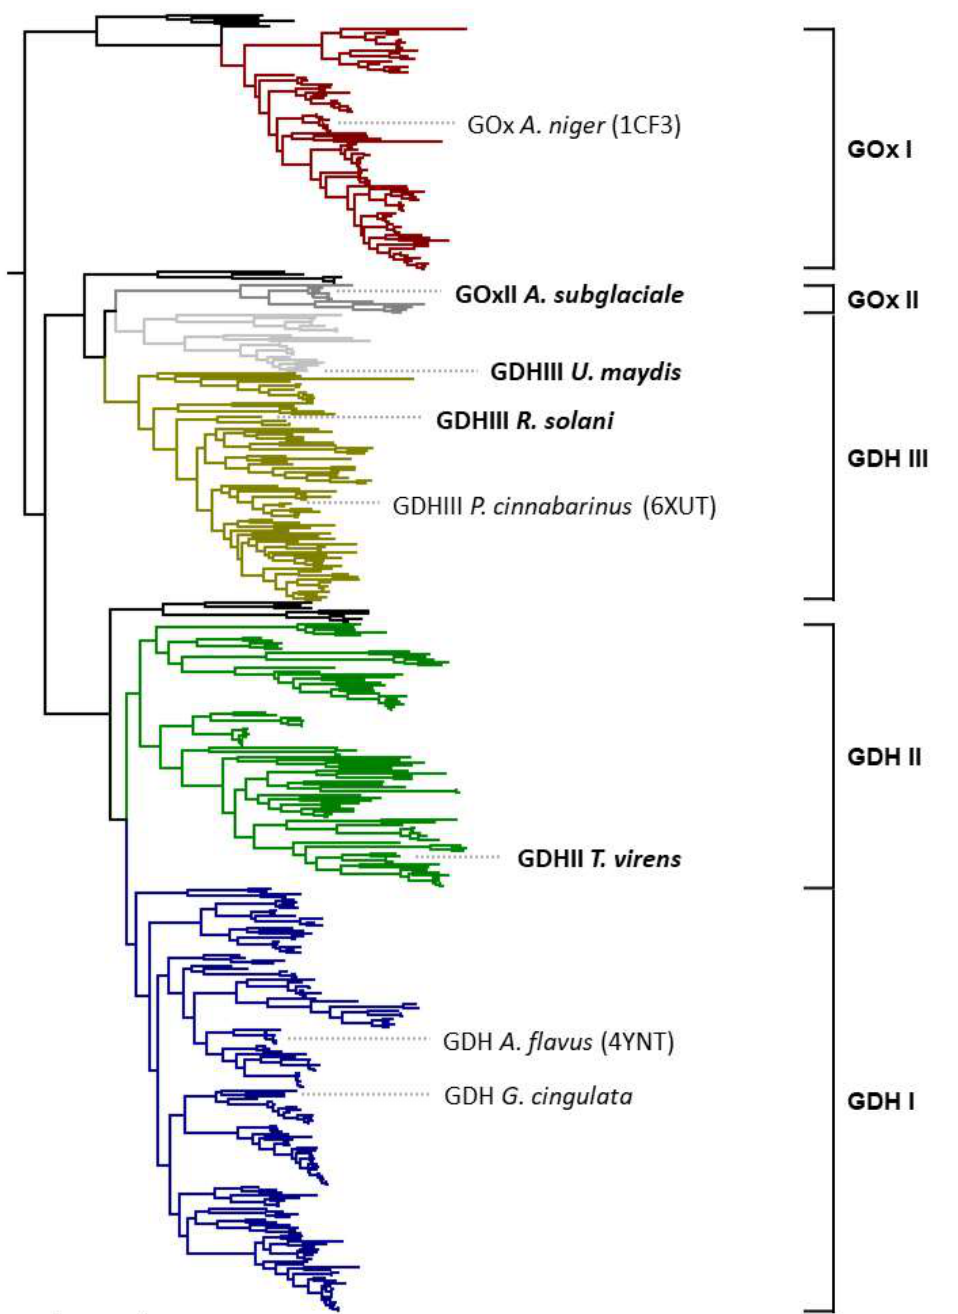
Figure 1. Phylogenetic tree of the AA3_2 glucose oxidoreductases and their detailed classification as previously reported [5]. The tree shows the main clades GOx I ( red ), GDH I ( blue ), GDH II ( green ), and GDH III ( yellow ). The minor GOx II clade is shown in dark grey, the minor subclade of GDH III containing only sequences of Ustilaginomycotina origin is shown in light grey. Novel GOx and GDH sequences selected for the present study are indicated in bold. The black bar indicates phylogenetic distance in amino acid substitution per site.